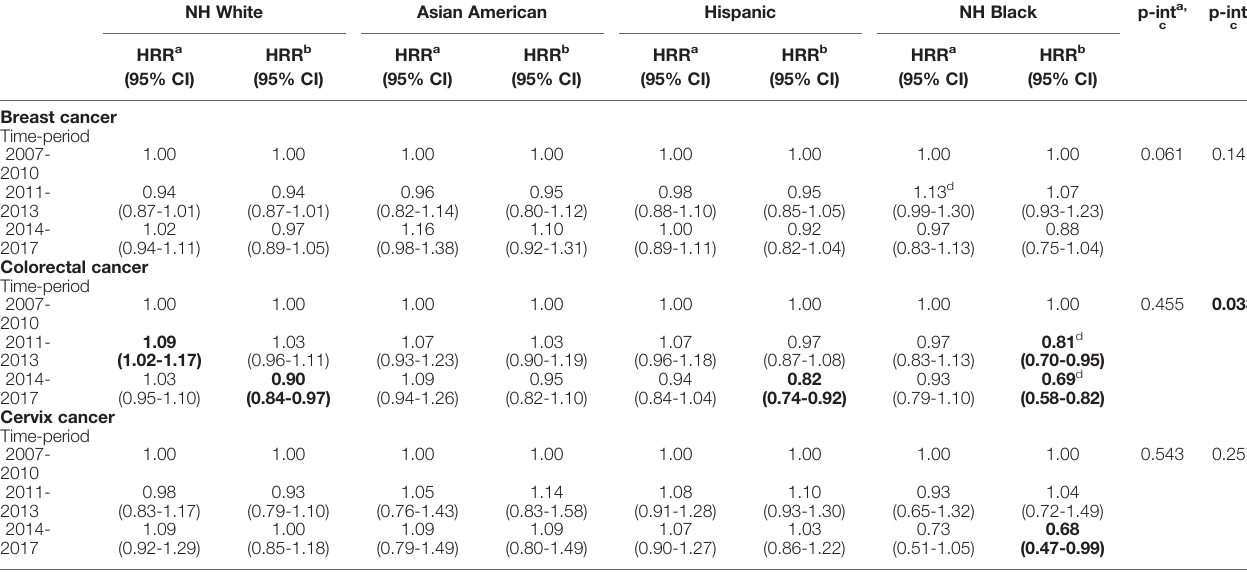
TABLE 3 | Risk of 5-year cancer-speci fi c death for time-period strati fi ed by race/ethnicity among breast, colorectal, and cervix cancer patients less than 65 years of age, California, 2007-2017. NH White Asian American Hispanic NH Black p-int a,